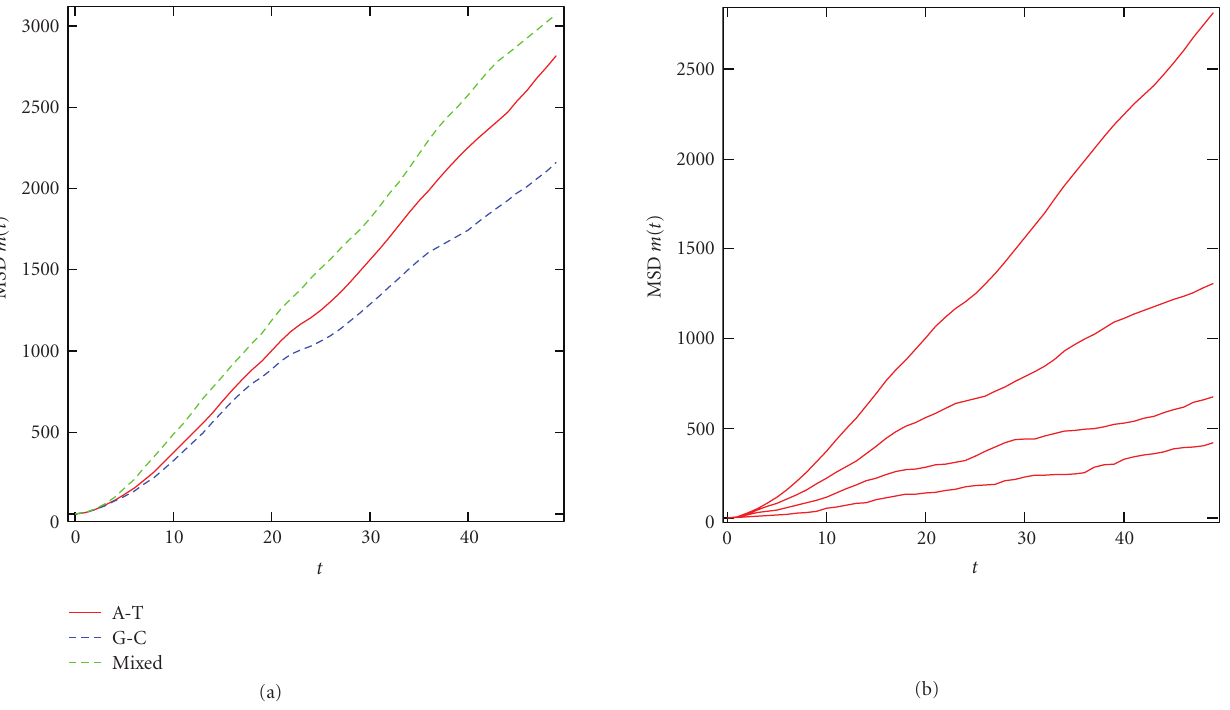
Figure 9: (a) MSD m ( t ) in A-T, G-C, and mixed models perturbed by M = 1, (cid:2) = 0 . 5. (b) MSD m ( t ) of A-T model perturbed by M = 1 for (cid:2) = 0 . 5,0 . 7,1 . 0,2 . 0 from above. We set r = 1. n 0